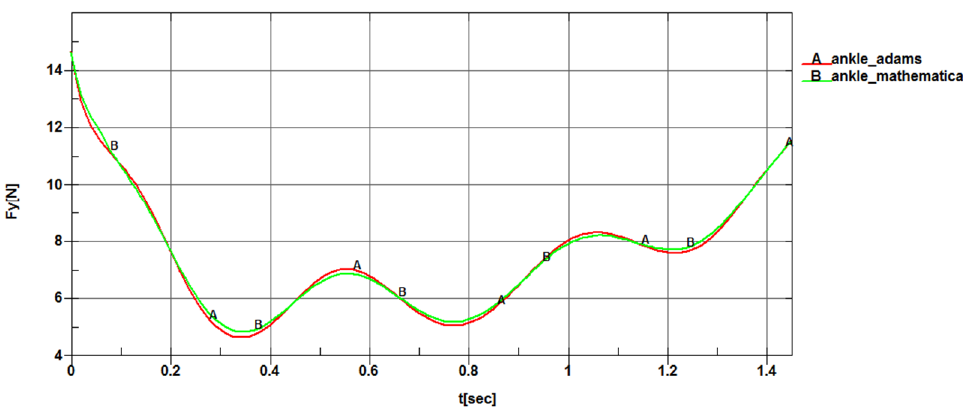
Figure 14. Connection forces component on y-axis for ankle joint vs. time (without ground contact).